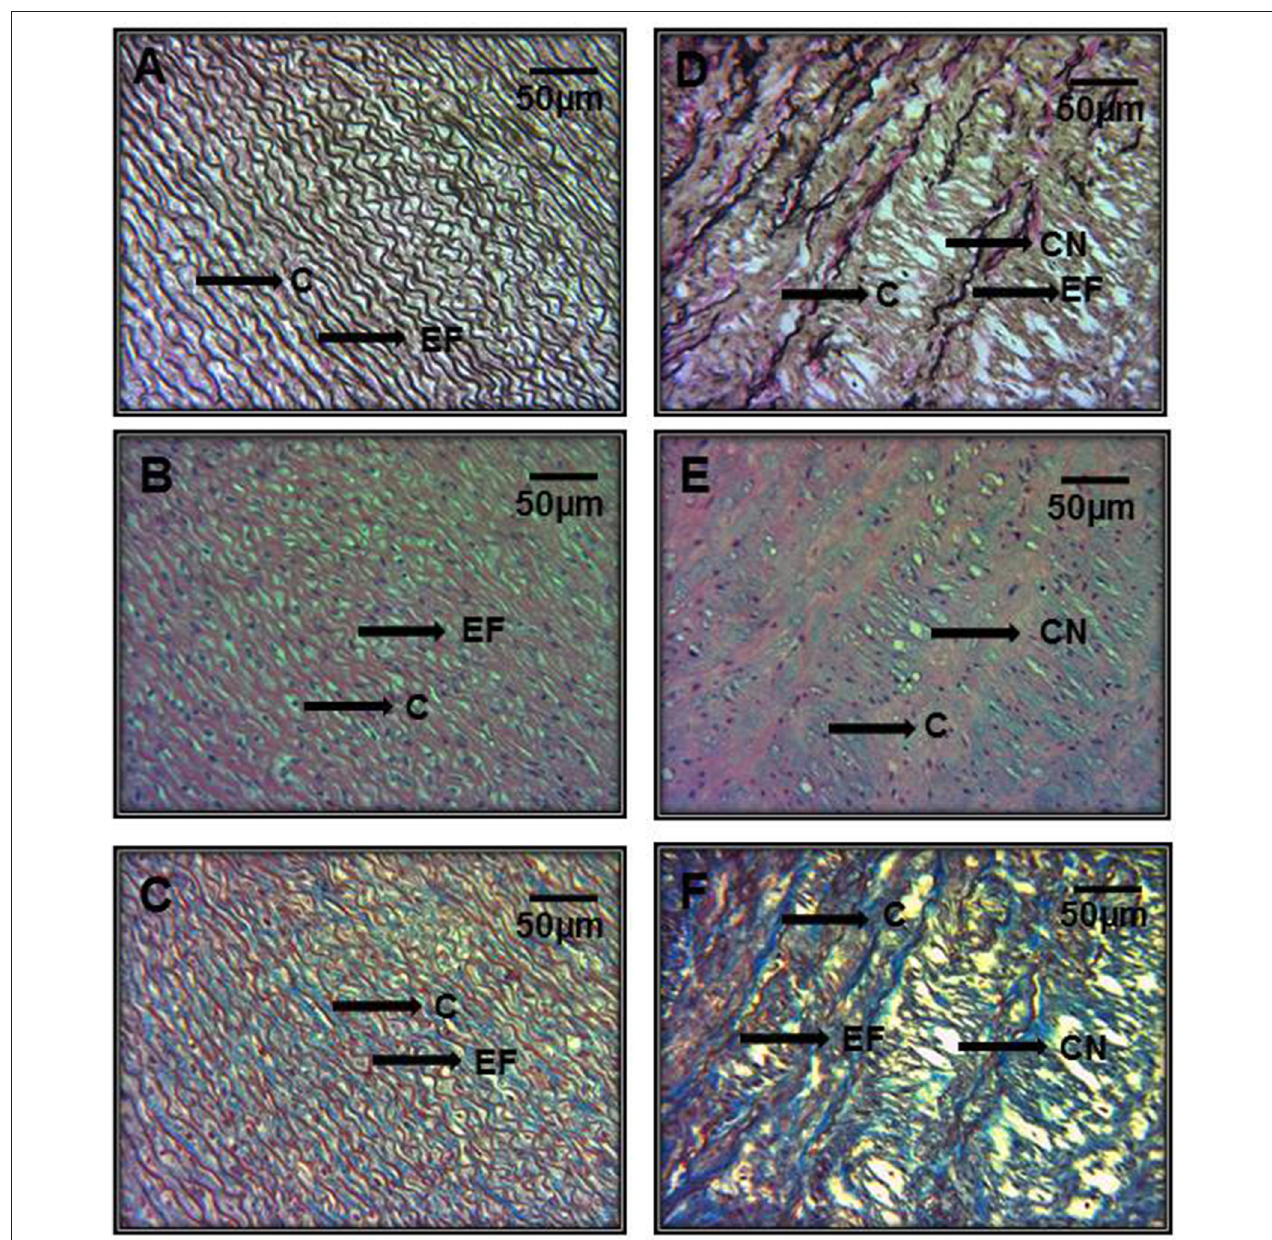
FIGURE 6 | Representative photomicrographs of the aortic root at a 40x magnification. Aortic root aneurysms of control subjects (A–C) and of MFS patients (D–F) . Sections were stained with same histological techniques as in Figure 5 . All MFS patients, had cystic necrosis, bundles of elastic fibers, thickening and rupture of elastic fibers, and increase in collagen between the elastic fibers in the aorta in comparison to C subjects. E, Endothelium; EF, elastic fibers; Col, collagen; CT, connective tissue; CN, cystic